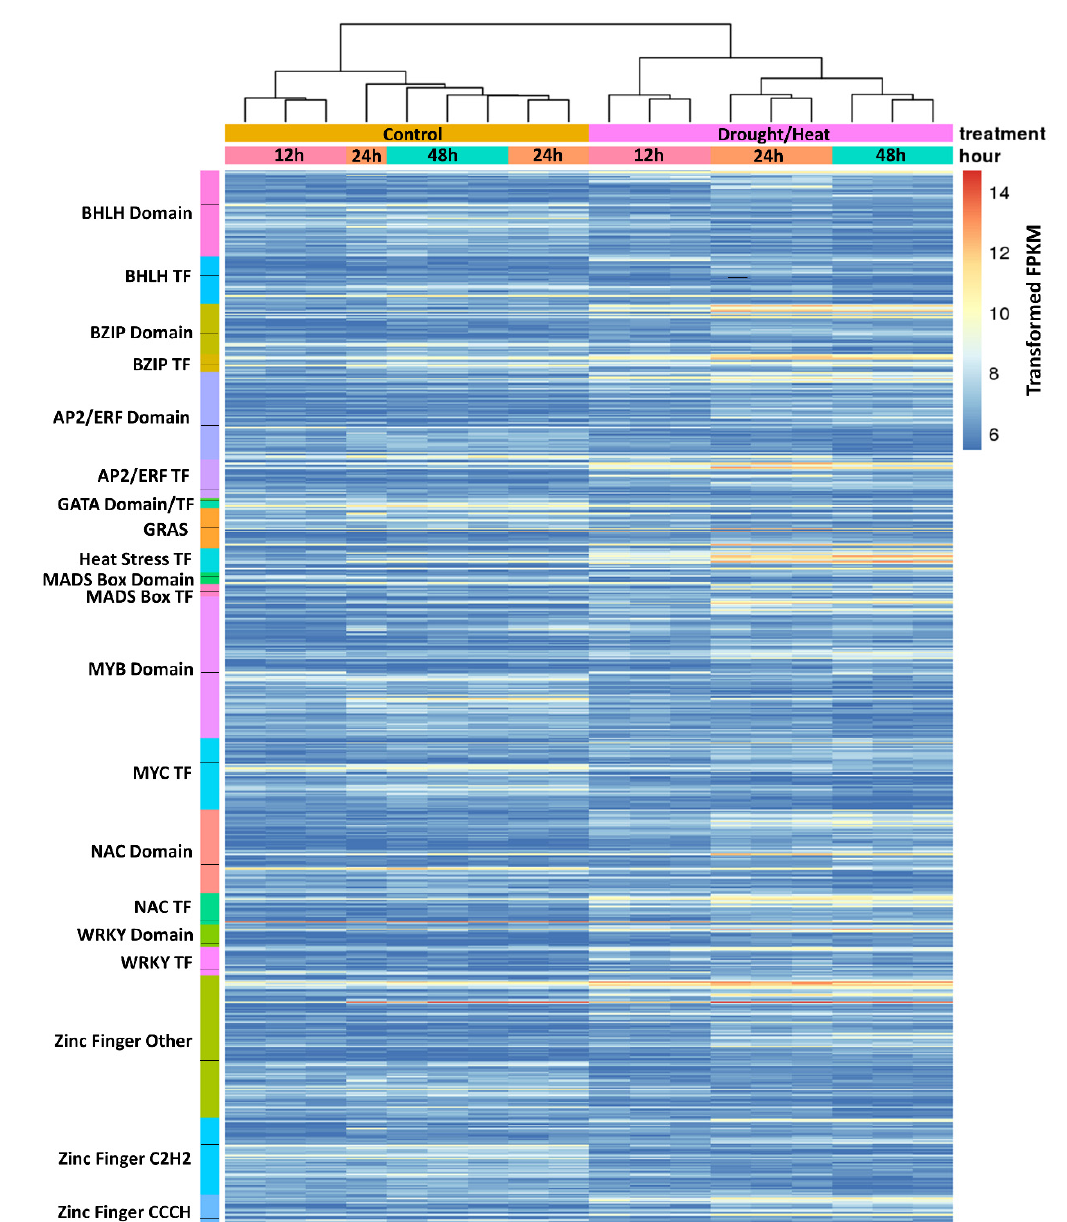
Figure 5. Heatmap of the 914 DEGs that are annotated as transcription factors or domain containing proteins and that also passed the differential expression filter of p -value 0.01, FDR 0.01, and log 2 -fold changes less than − 2 or greater than 2 in at least one time point. Values were transformed with variance stabilizing transformation. Gradient bar on the right side of the heat map represents the transformed value of fragments per kilobase per million reads (FPKM). Treatments (control and heat/drought) and treatment times of 12, 24, and 48 h are as shown. Gene groups of transcription factor DEGs are shown to the left of the rows. Lines in each transcription factor class on the left axis separate the up- and down-regulated DEGs in each class. Samples (columns) are clustered using Euclidean distance and a dendrogram is shown above the heatmap. For the specific expression data for each individual transcription factor represented in the heatmap, see Supplementary Table S3. Another category of zinc finger proteins with a very high number of DEGs, but not included in the heat map, are the ZF-rvt (reverse transcriptase)